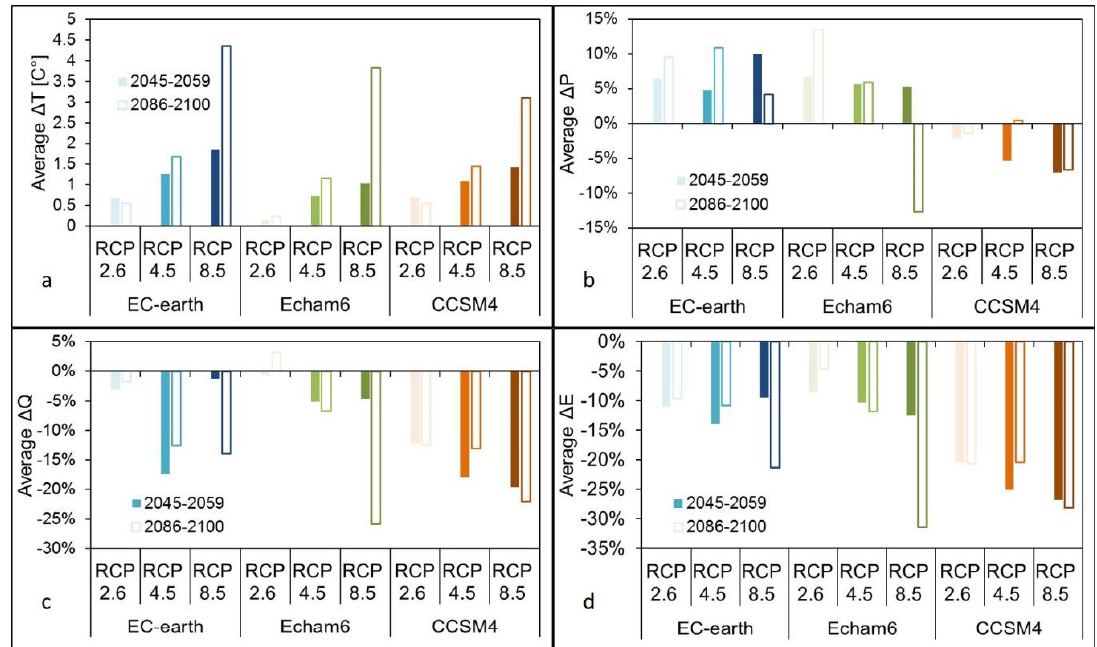
Figure 7. Variables change along the century against the Control Run period (2000–2017 for T, P, Q, 2005–2017 for E). Periods P1 (2045–2059), and P2 (2086–2100) AWS Formazza. ( a ) Temperature change (°C). ( b ) Precipitation change (%). ( c ) Discharge change (%). ( d ) Energy production change (%).